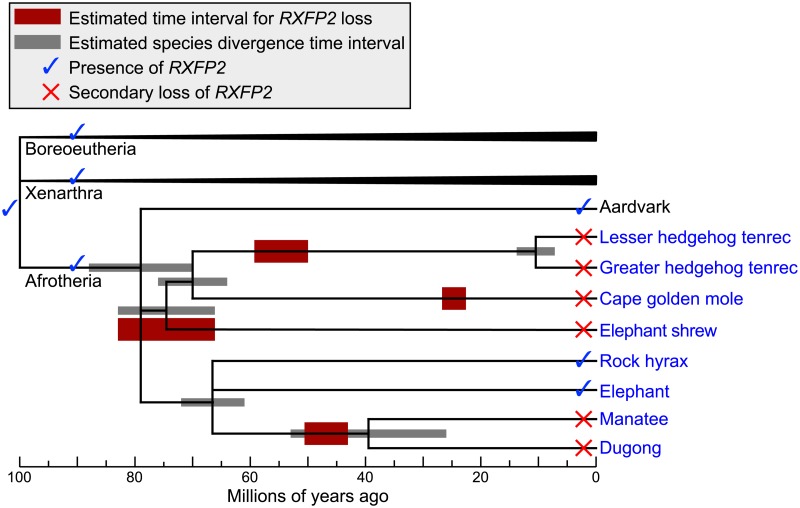
Evolution of RXFP2 and estimated time intervals during which RXFP2 came under neutral evolution.Red boxes represent a lower and upper bound for an estimated time interval during which RXFP2 started to evolve neutrally (Materials and methods, S2 Table), which shows that the gene was lost independently at different time points. Gray boxes represent an estimated interval for species divergence times taken from TimeTree [57] (see also S4 Table). Species in blue font are testicond. The phylogenetic position of tenrecs, golden moles, elephant shrews is well supported by morphological and molecular characters [23, 24, 26]. Uncertain phylogenetic relationships are shown as a polytomy. Note that while the loss of RXFP2 in the elephant shrew is estimated to have happened at the base of the lineage, this loss is clearly independent from the much later loss in the tenrec and in the golden mole lineage. Evidence for the loss of RXFP2 in the dugong and the greater hedgehog tenrec was obtained by PCR and sequencing experiments (S5 Fig). RXFP2, relaxin/insulin-like family peptide receptor 2.